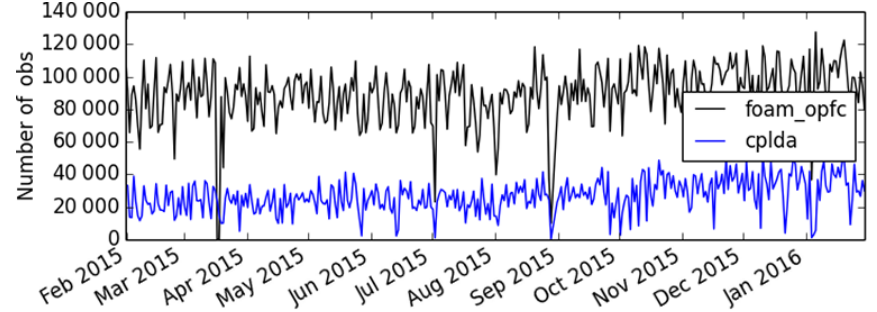
Figure 2. Daily number of SLA observations assimilated in the FOAM operational system for 2015 (black line, foam_opfc) and in the CPLDA 2015 experiment (blue line,